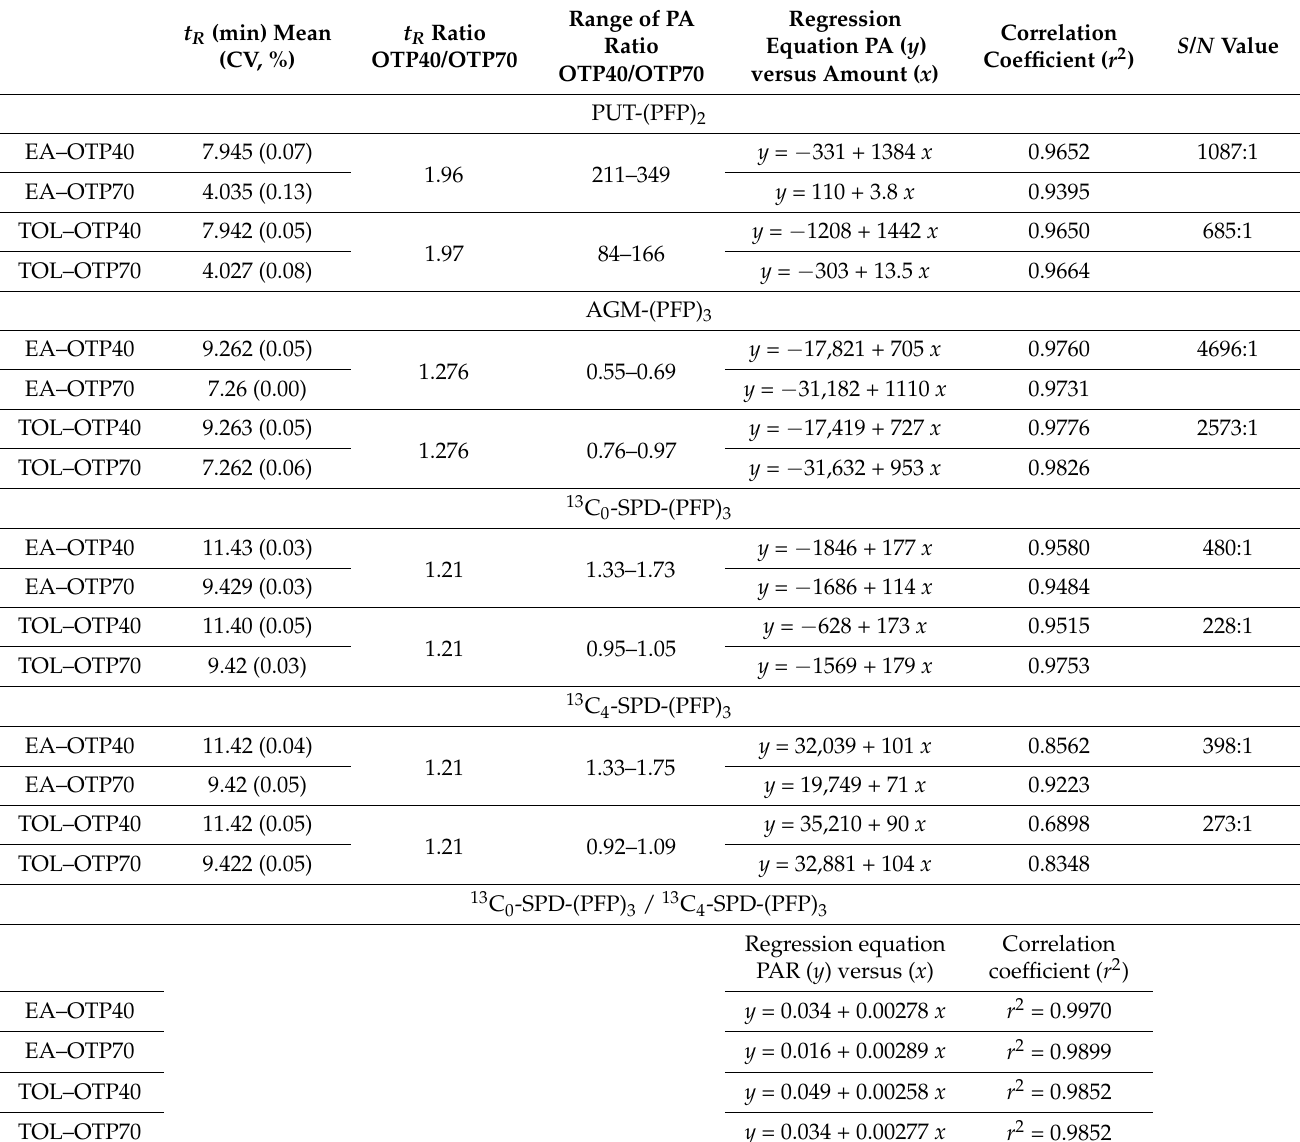
Table 1. Summary of the results retention time ( t R ) and peak area (PA) of the PFP derivatives, linearity between PA ( y ) and amine amount (x), and signal-to-noise ( S/N ) values using ethyl acetate (EA) or toluene (TOL) and two starting oven temperatures.